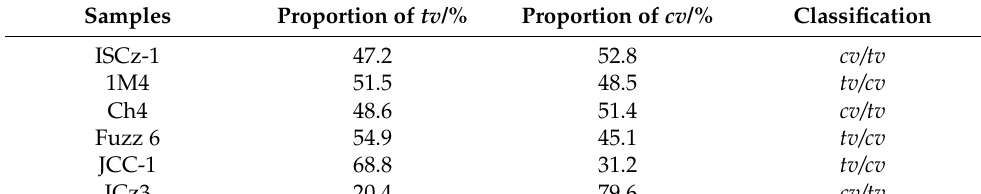
Table 5. The proportions of trans- (tv) and cis-vacant (cv) layers of samples and the classification.